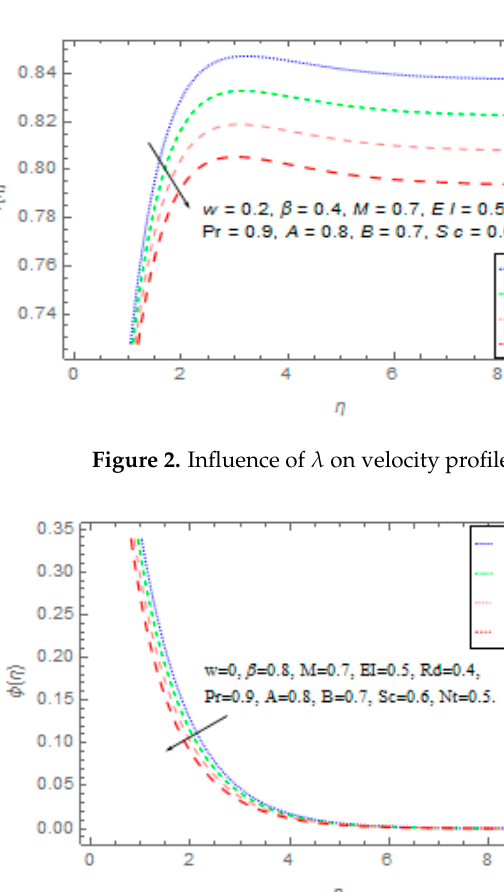
Figure 3. Influence of λ on concentration φ ( η ) .